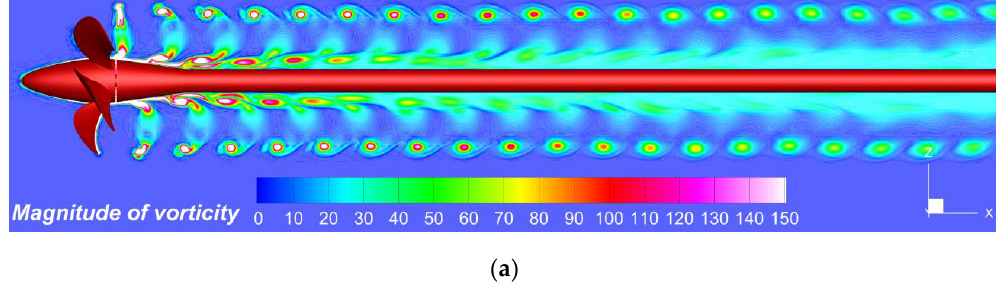
Figure 7. Non-dimensional pressure field computed in the domain longitudinal plane of symmetry. ( a ): 𝐽 = 0.6418 ; ( b ): 𝐽 = 1.4422 . ( a ): J = 0.6418; ( b ): J = 1.4422.